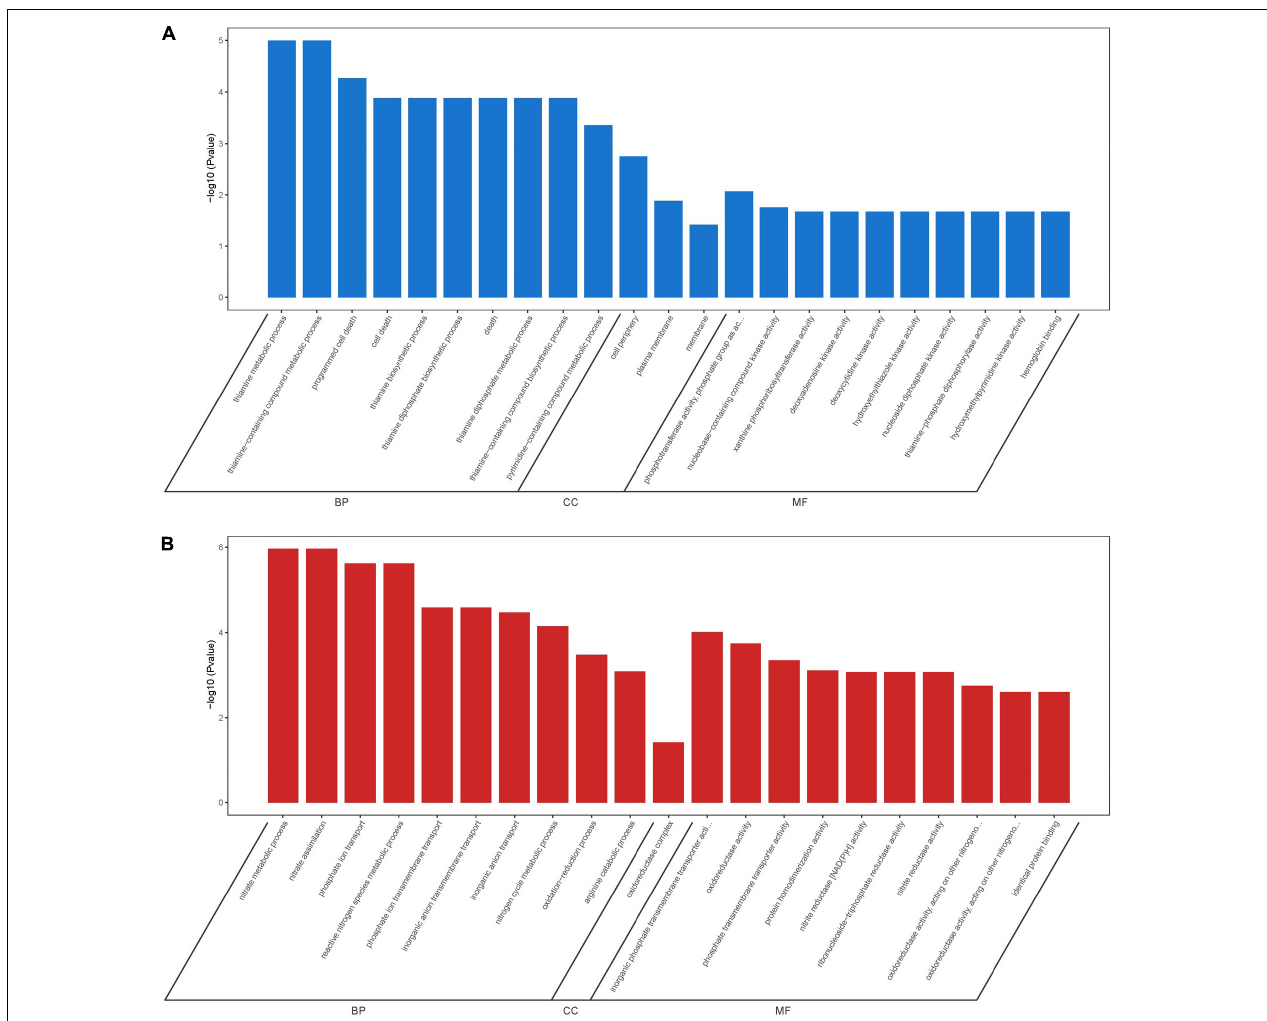
FIGURE 10 | GO enrichment analysis of overlapping DEGs in both compounds 6 and 12 treatment groups. Significantly downregulated GO terms (A) are shown in blue, and significantly upregulated GO terms (B) are in red. BP, biological process; CC, cellular component; MF, molecular function.